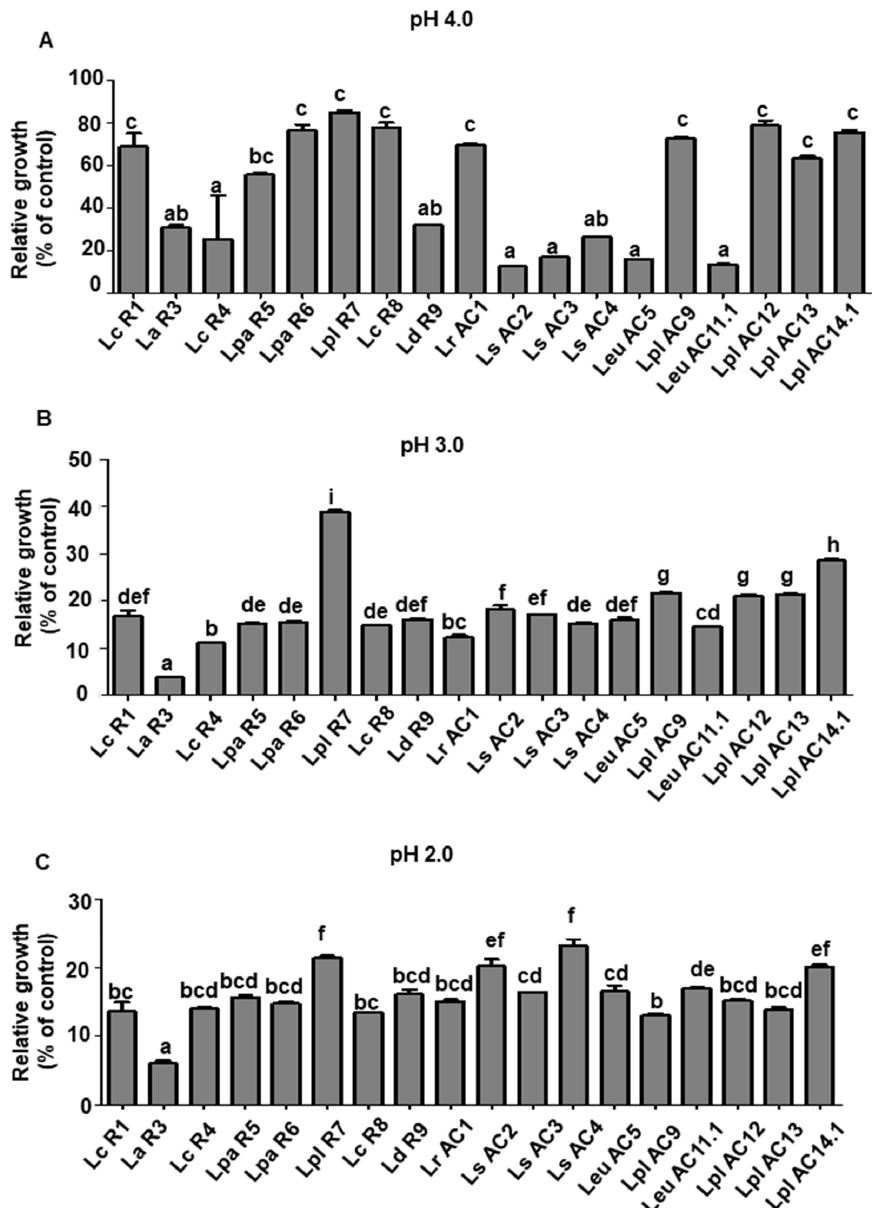
Figure 1. Relative growth of selected LAB isolates in the MRS broth with pH 4.0 ( A ), pH 3.0 ( B ), and pH 2.0 ( C ) at 24 h of incubation. Relative growth was determined by the ratio of OD 600 of LAB cultures grown in the MRS adjusted to different pH to that in the regular MRS. Graph bars marked with different letters on top represent statistically significant results. The results were compared by one-way ANOVA and Turkey post hoc test; p < 0.05; n = 2. Lc, L. casei; La , L. acidophilus; Lpa , L. paracasei; Lpl , L. plantarum; Ld , L. delbrueckii; Lr , L. rhamnosus; Ls , L. sakei; Leu , Leu. mesenteroides.